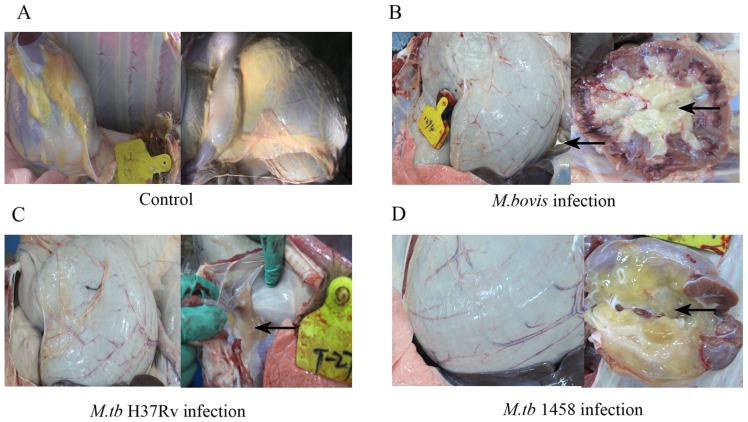
Gross pathological observations of the calves.The subcutaneous adipose tissues were very thick in the negative control group (A). The calves had thinner layers of subcutaneous adipose tissue and obviously gelatinous materials after infection with M.bovis (B), M. tbH37Rv (C), and M. tb 1458of bovine origin (D). Arrows indicate the gelatinous tissue material.